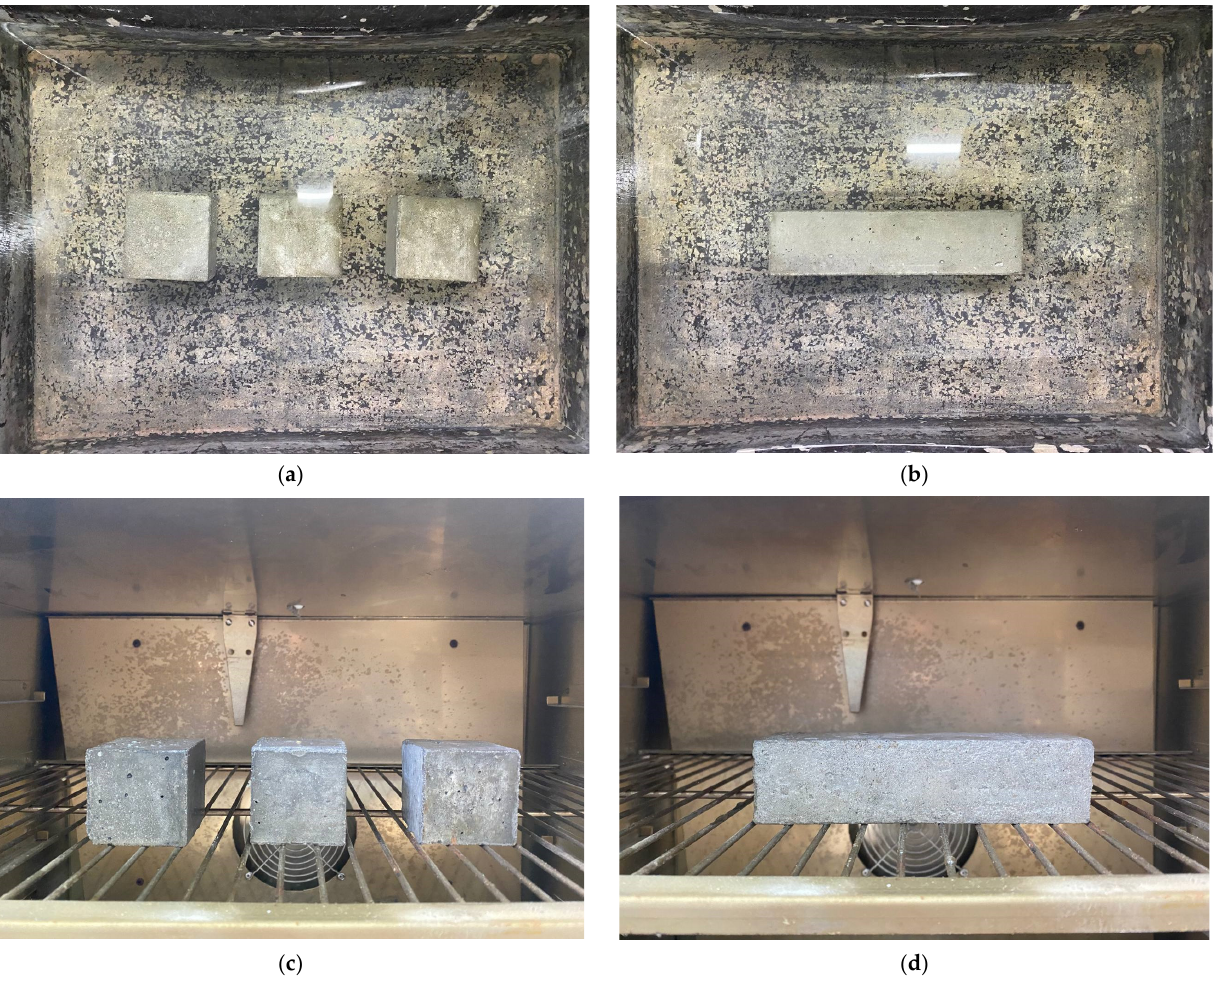
Figure 5. Testing samples for resistance to humidification and drying cycles: ( a ) humidification of sample cubes; ( b ) wetting of prism specimens; ( c ) drying of sample cubes; ( d ) drying the prism specimens.